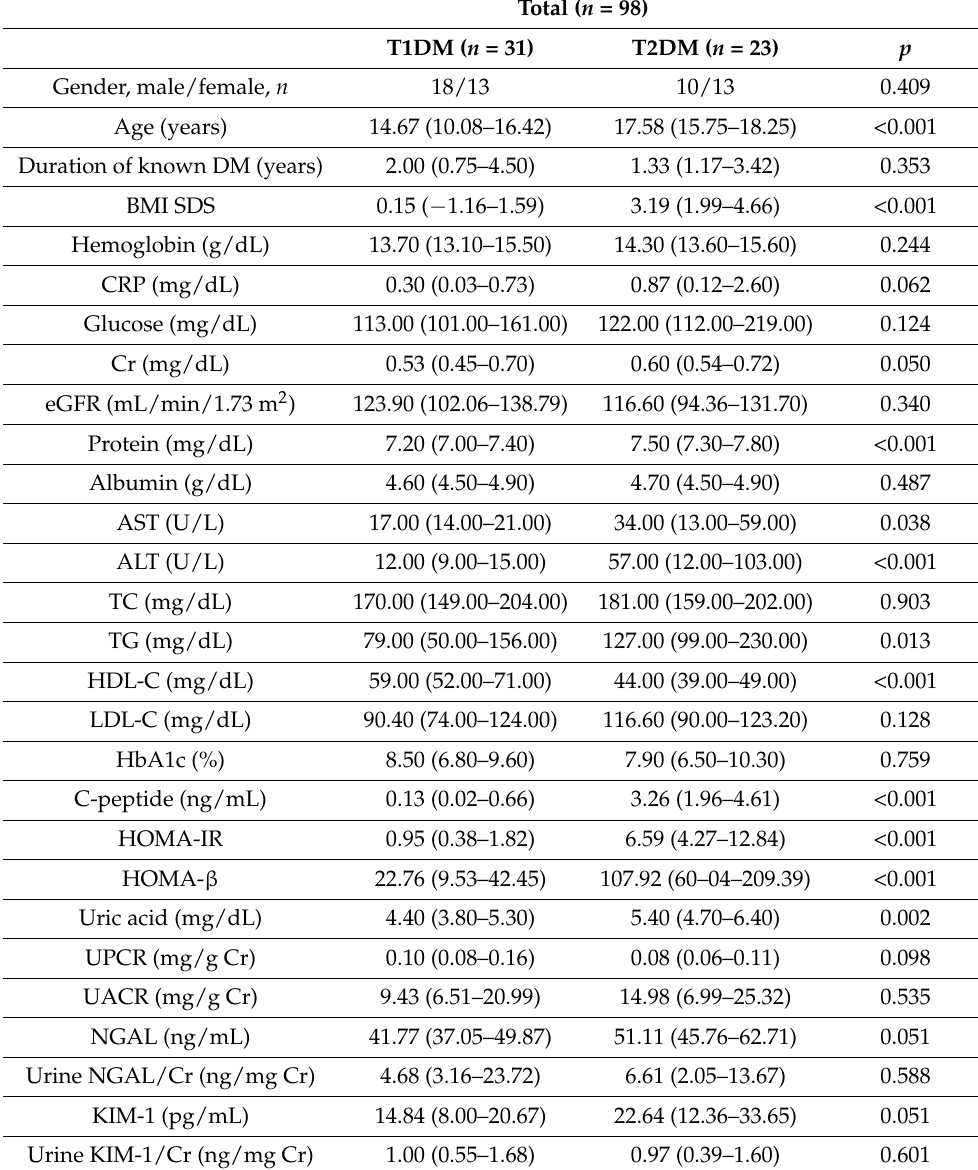
Table 2. Clinical characteristics and plasma and urine biomarker measurements of diabetic children with regard to the type of